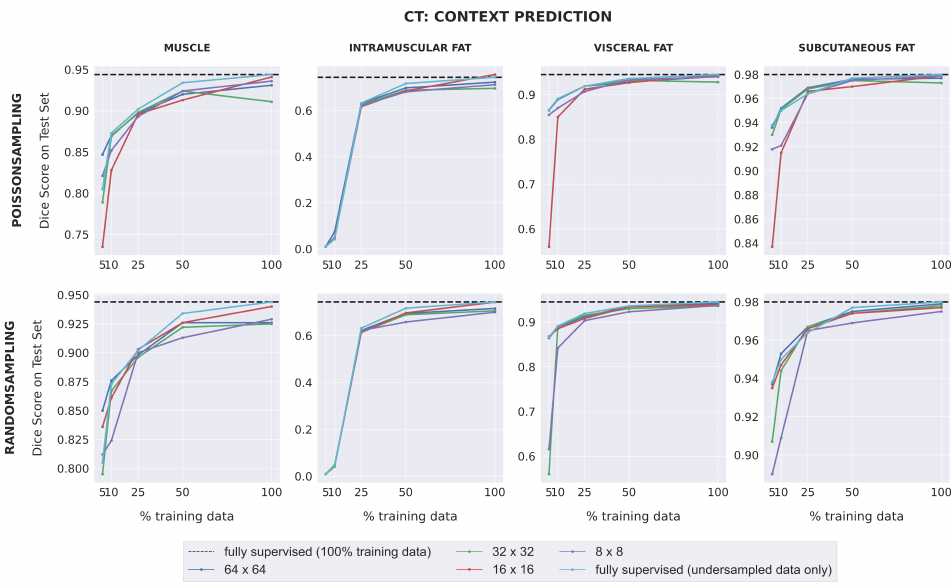
Figure A3. The downstream segmentation performance on the CT dataset for the Context Prediction pretext task as measured by the Dice score for every combination of patch size and sampling method used during pretraining, evaluated in five different scenarios of training data availability. In each scenario, every model is trained for segmentation using one of the five different subsets of training data as described in Section 2.1.2. The black dotted line in each plot indicates the performance of a fully-supervised model trained using all available training images. The light blue curve indicates the performance of a fully-supervised model when trained using each of the five different subsets of training